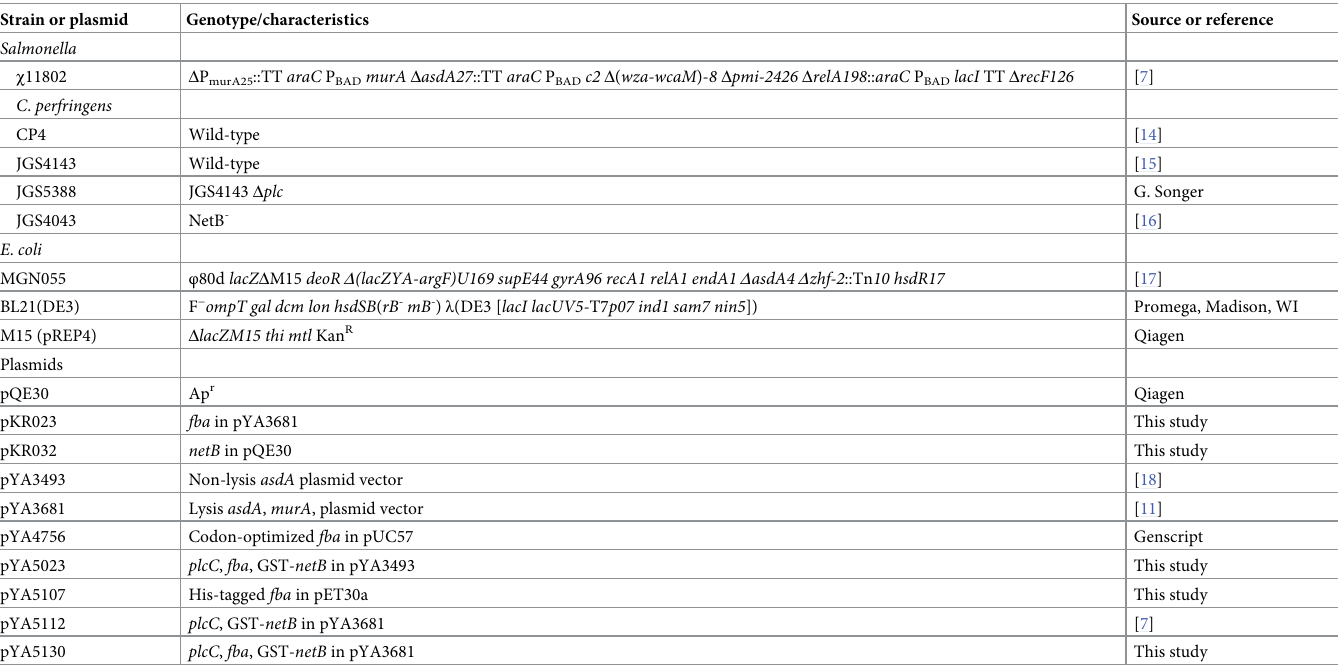
Table 1. Strains and plasmids used in this study. Strain or plasmid Genotype/characteristics Source or